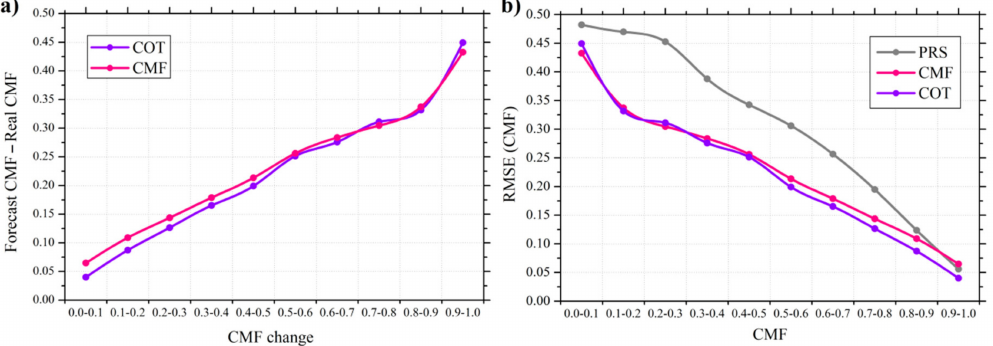
Figure 9. Absolute di ff erence between the forecast and real CMF for 15 min ahead as a function of the CMF change ( a ). The RMSE in terms of CMF for the same forecast time horizon for various CMF classes ( b